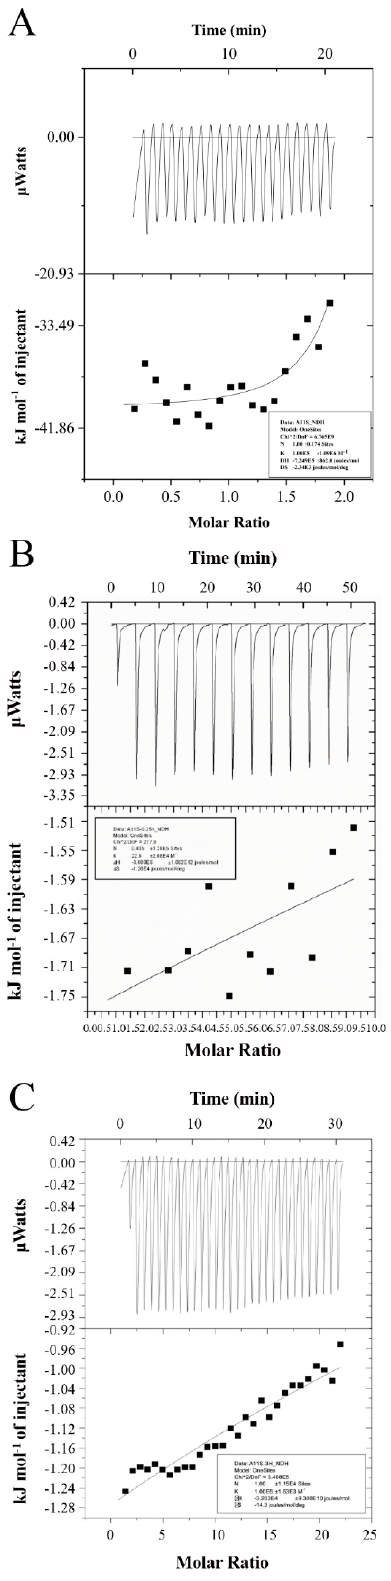
Figure 5. ITC determination of the binding of MEL-A to 11S. The upper panel shows heat flows obtained upon injection of MEL-A solution into the 11S solution at 25 ◦ C. The lower panel indicates the molar heat values obtained through the integration of the individual heat flow signals as a function of the MEL-A concentration. ( A ) native 11S; ( B ) 11S heating 0.25 h; ( C ) 11S heating 3.0